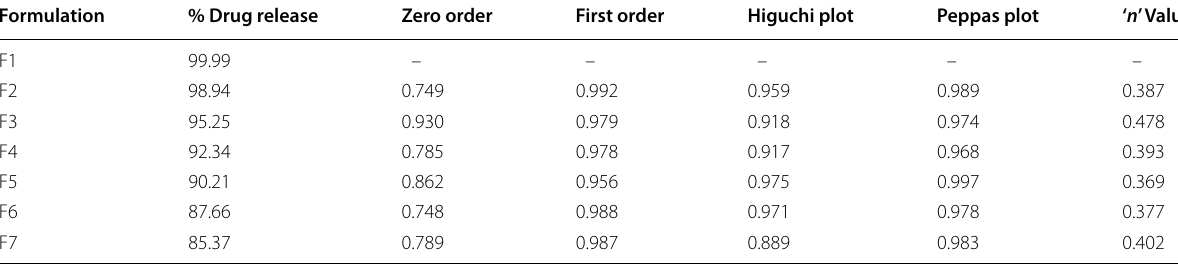
Table 2 Correlation coefficients according to different kinetic equations